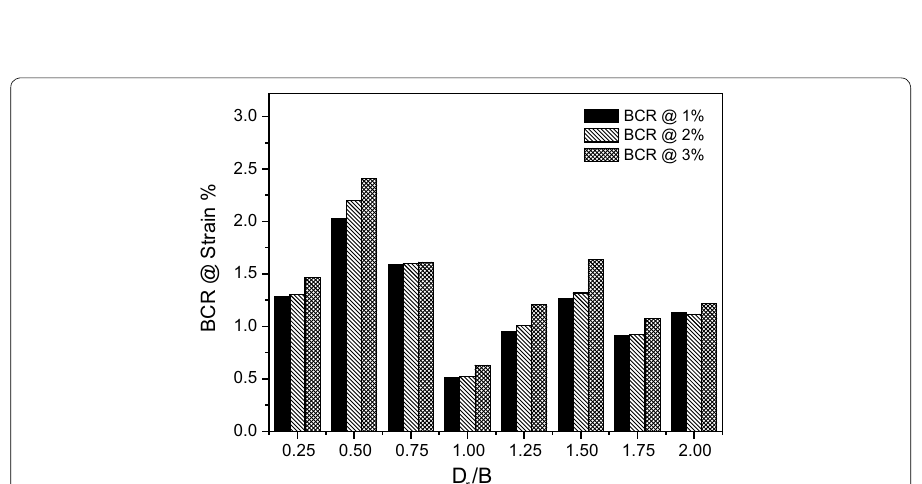
Fig. 6 BCR of reinforced soil for 1, 2 and 3% strain for 50 mm square